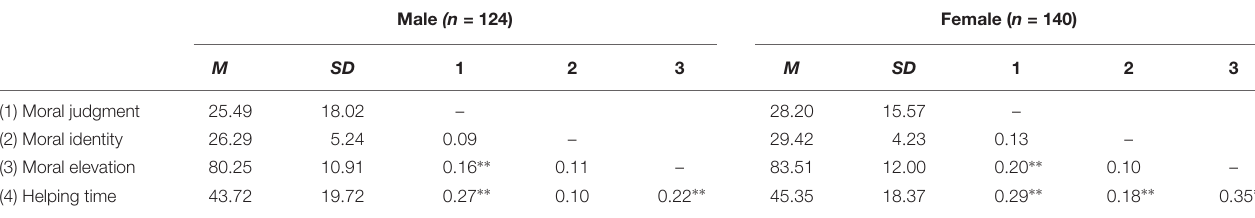
TABLE 1 | Descriptive statistics and correlation matrix.